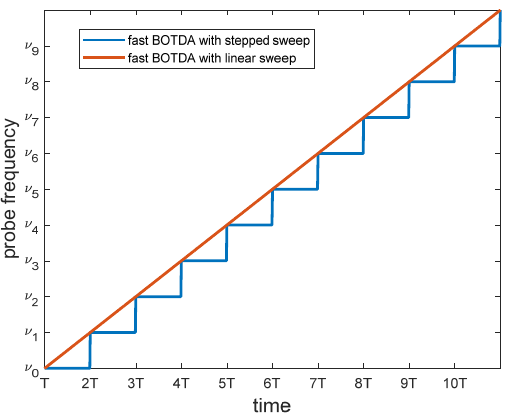
Figure 20. Probe frequency sweep used for stepped sweep [67] and linear sweep [69] BOTDA measurements. 𝑇 represents the time slot allocated for the acquisition of each Brillouin gain profile (in the ideal case, e.g., no averaging, 𝑇 corresponds to the roundtrip time of the pump pulse over the fiber length).